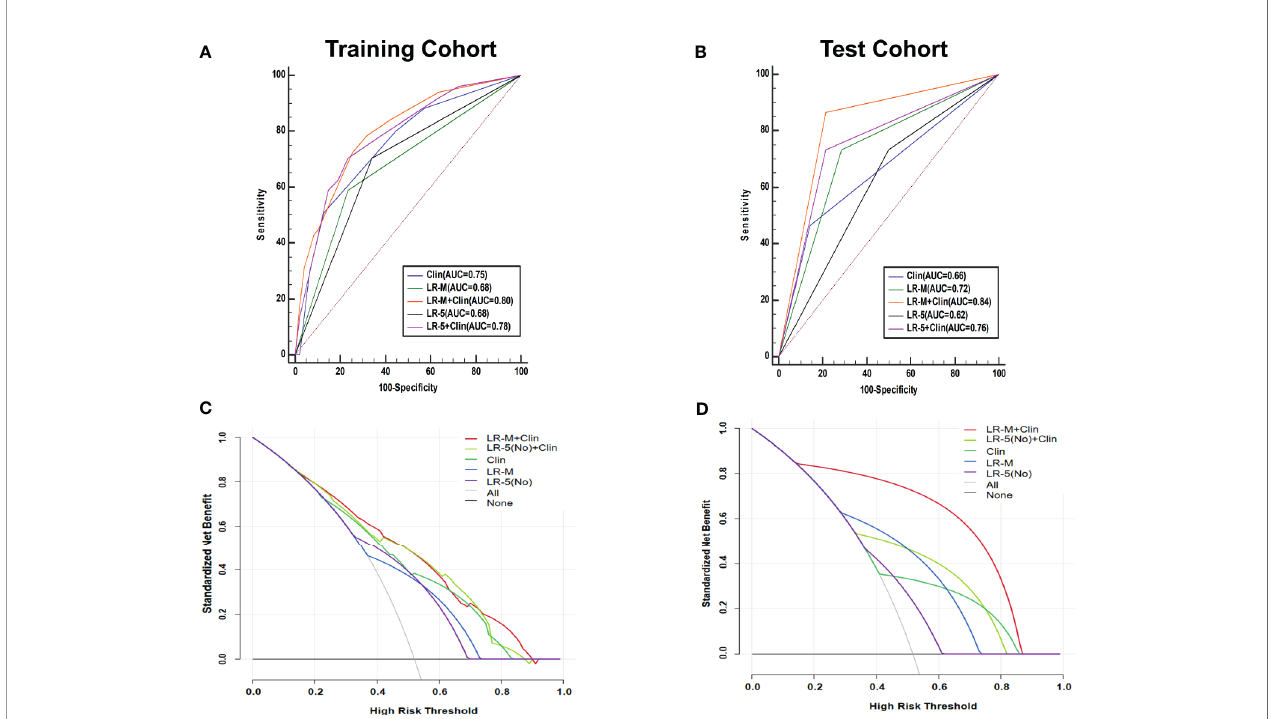
FIGURE 5 | AUC graphics of all models for predicting MVI in HCC patients in the training (A) and test cohort (B) . Decision curve graphics of all models for predicting MVI in HCC patients in the training (C) and test cohort (D) . In the decision curve, the y-axis represents net bene fi t and the x-axis is the value of the different probability, illustrating the trade-offs between bene fi t (true positives) and harm (false positives) as the threshold probability (preference) is varied across a range of reasonable threshold probabilities. Clin, clinical information; HCC, hepatocellular carcinoma; MVI, microvascular invasion; CEUS; contrast enhanced ultrasound; LR-5, liver imaging reporting and data system category 5; LR-M, liver imaging reporting and data system category